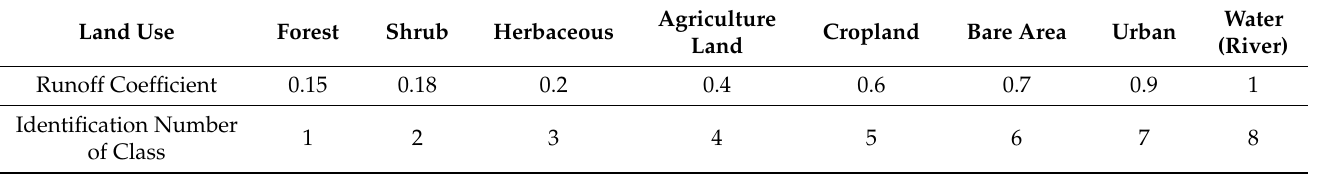
Table 2. Land use pattern and corresponding runoff coefficients in the Galikesh River